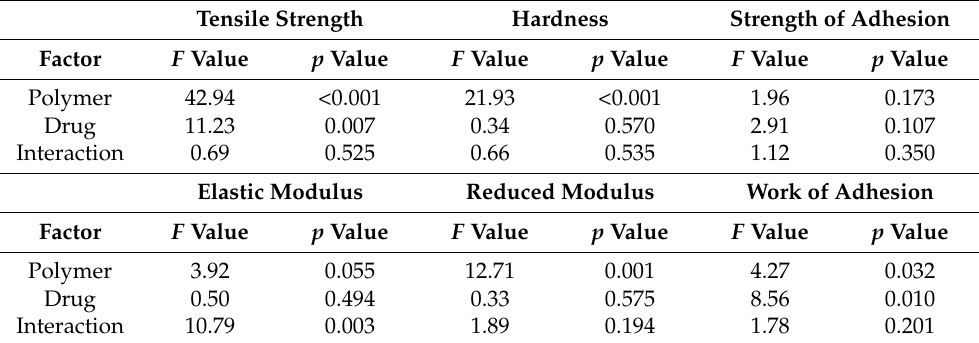
Table 3. The results of ANOVA tests for the obtained mechanical and mucoadhesive properties. Tensile Strength Hardness Strength of